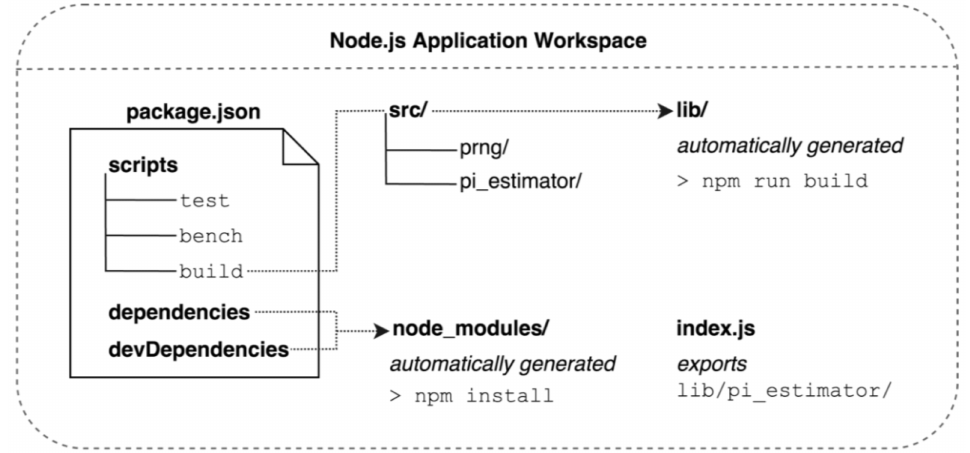
Figure 2. Pure JavaScript Node.js application